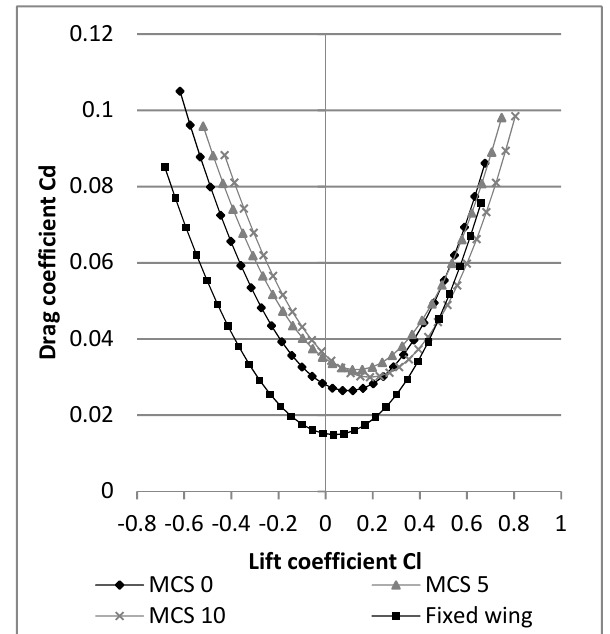
Figure 28. Drag coe ffi cient variation with lift coe ffi cient for the Figure 28. Drag coefficient variation with lift coefficient for the UAS-S4.